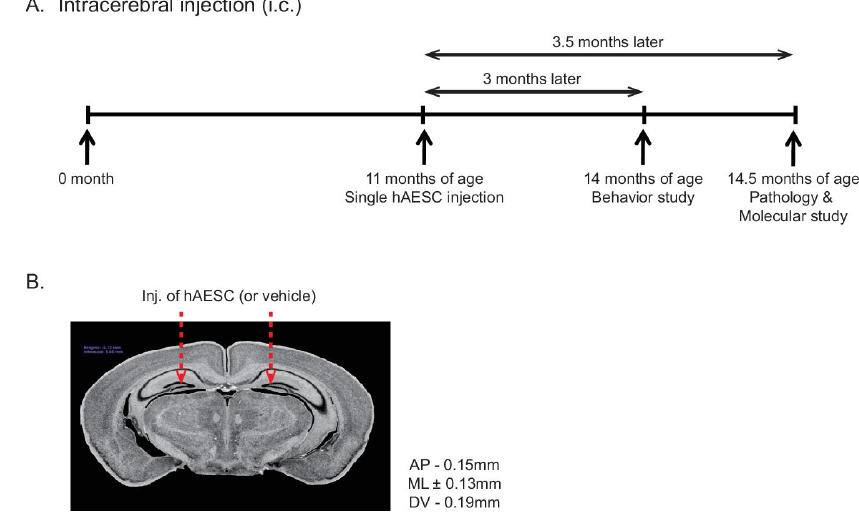
Figure 1. Experimental schemes. ( A ) Experimental scheme for the behavioral tests and intracerebral injections. ( B ) Stereotaxic coordinates of the intracerebral injection sites. The red arrows indicate the injected site of hAESCs (or